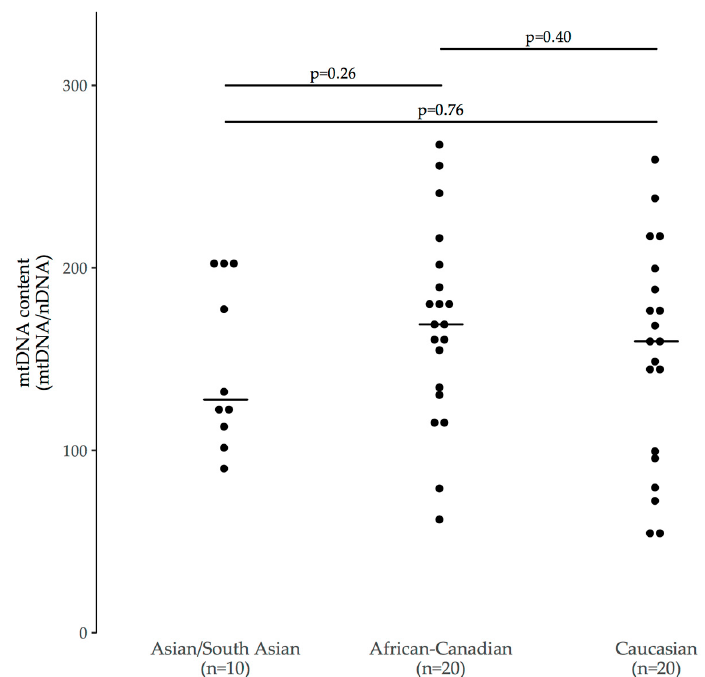
Figure 3. Univariate between-group comparisons for three sex- and age-matched (1:2) groups of HEU children without ASD ( p -values calculated via Student’s t -test). Lines indicate medians.